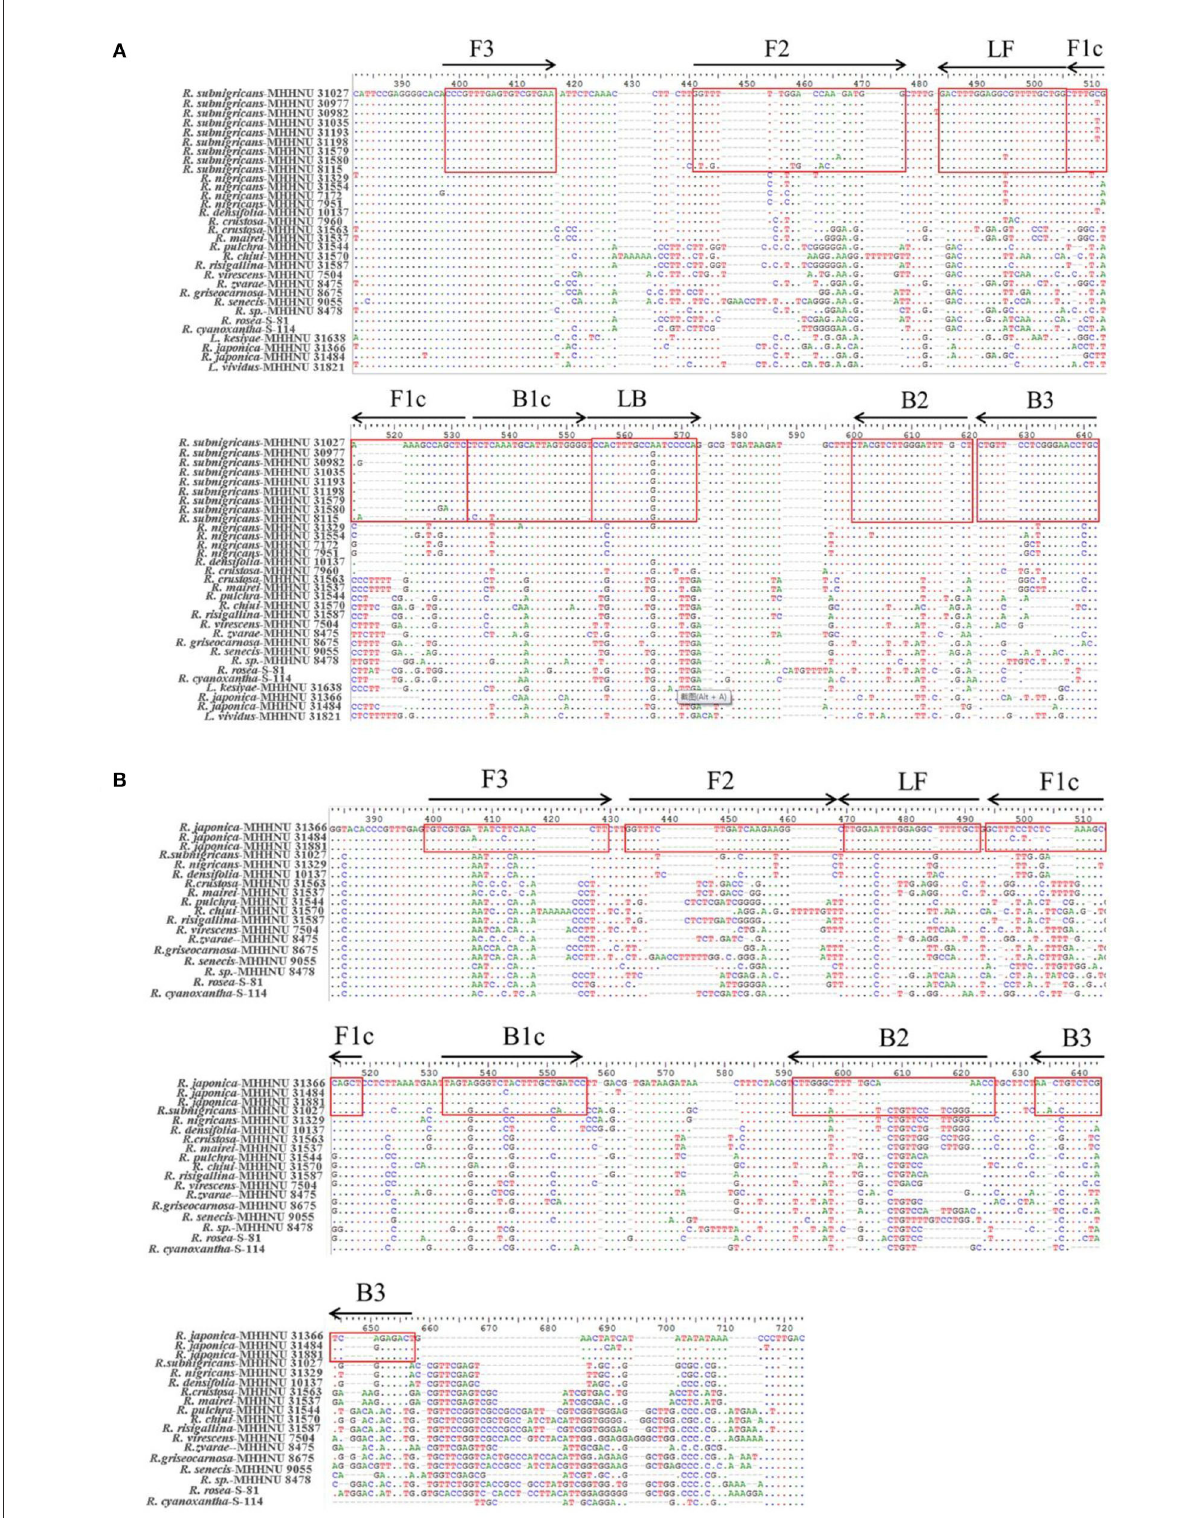
FIGURE2 Multiple-sequence alignment of internal transcribed spacer (ITS) of Russula samples. The target regions used for designing loop-mediated isothermal amplification (LAMP) primers were labeled. LAMP primers for R. subnigricans (A) and LAMP primers for R. japonica (B)